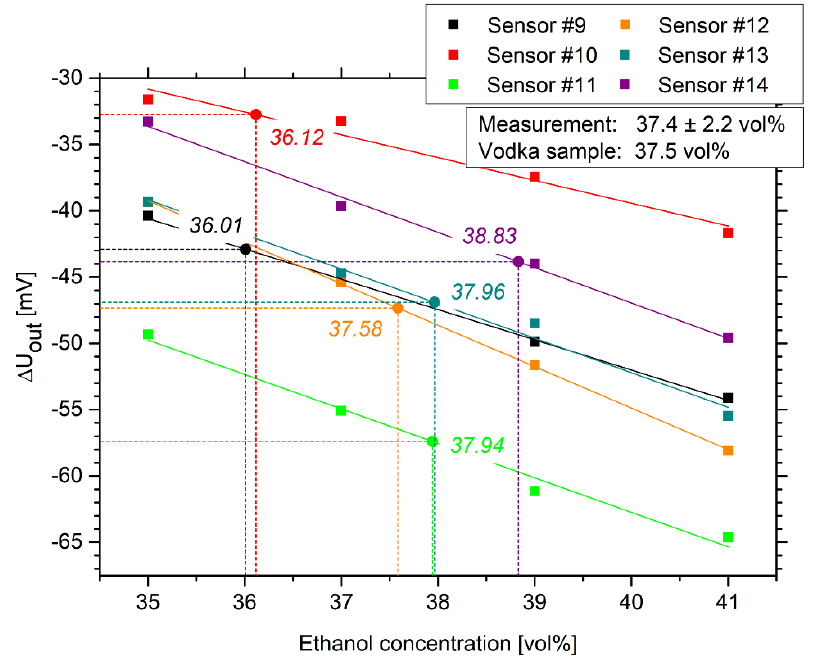
Figure 8. Calibration curves for the hydrogel-based ethanol sensors used for the determination of the ethanol concentration of a vodka sample (“Wodka Gorbatschow” with 37.5 vol% ethanol)